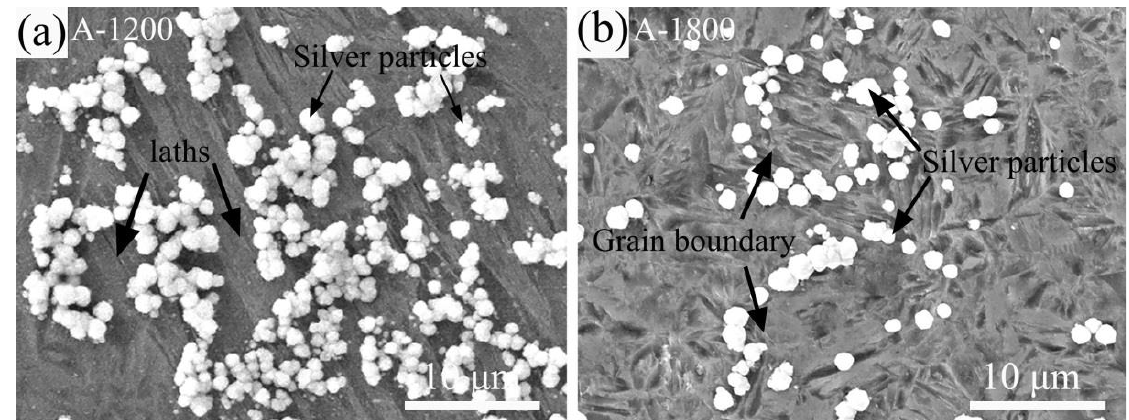
Figure 6. Locations of hydrogen accumulation in samples charged for 120 min: ( a ) A-1200 and ( b ) A-1800.